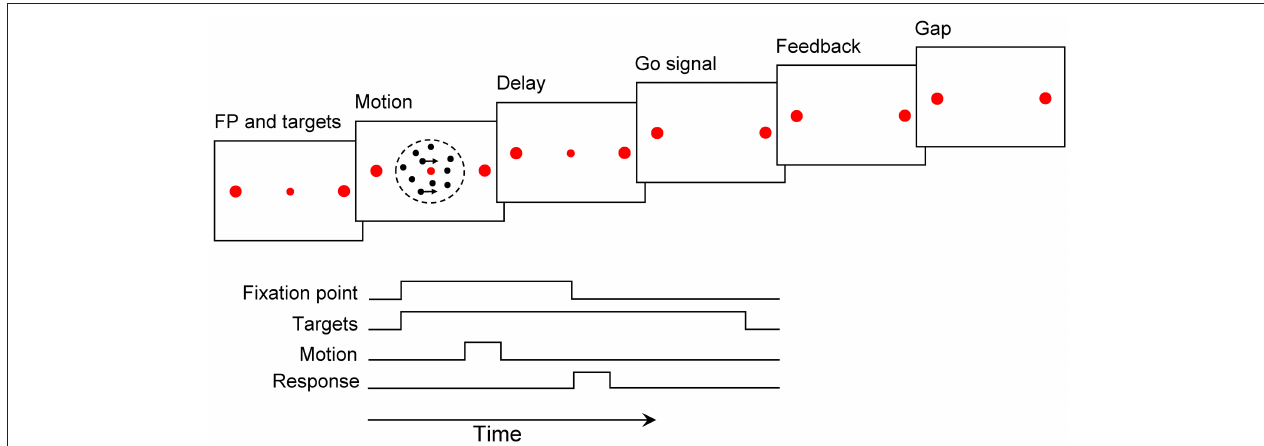
FIGURE 1 | Motion discrimination paradigm. A fixation point (FP) and two targets were presented for 200ms. After that, the motion stimulus was shown for 120, 400, and 720ms. The Go signal followed by a 120ms delay period cued participants to report their decision, within 1s, by pressing two specific keys. Auditory feedback was played for 100ms. The following trial began after a gap of 0–1.2s (see Materials and Methods).